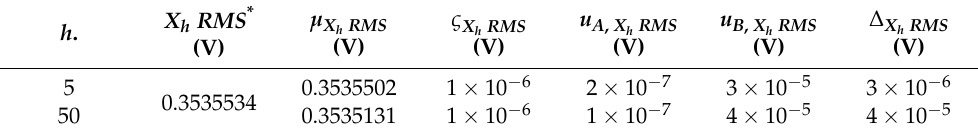
Table 6. Steady-state single harmonic component signal characterization results. h .